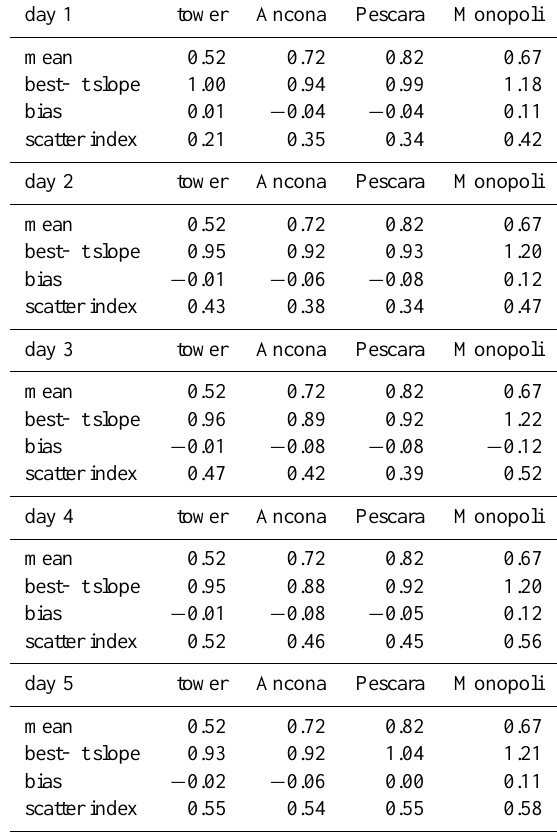
Table 4. Statistics for the comparison between the forecasts of the significant wave heights at different range (one to five days) and the corresponding analysis. The locations considered are the ISMAR oceanographic tower and the three wave recording buoys. See Fig. 3 for their positions. The considered period is